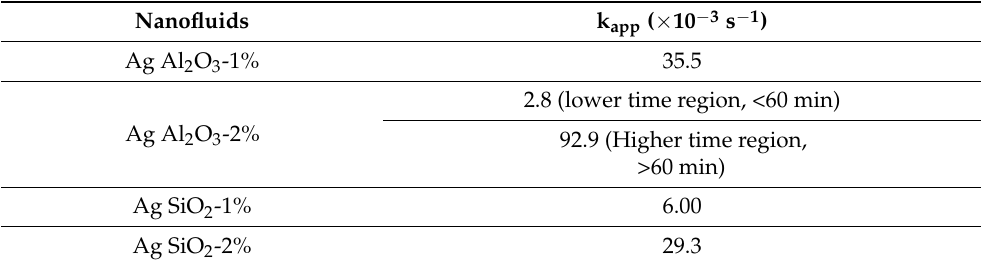
Table 5. k app values of Al 2 O 3 @Ag NF and SiO 2 @Ag NF (1% and 2% weight